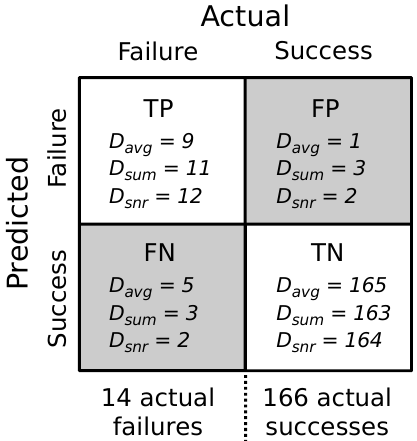
Fig. 7. The confusion matrix for predictions of 180 simulations in study 3 using the SVM committee with three different decision criteria ( D avg , D sum , and D snr ).